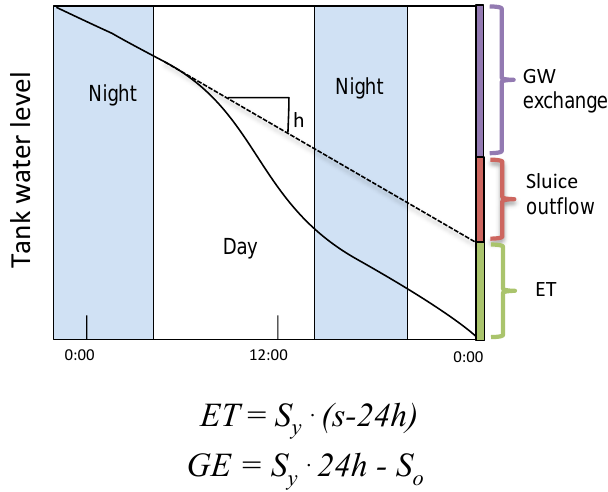
Figure 3. The White method for estimating ET and groundwater exchange using diurnal water level fluctuations. Grey bars denote